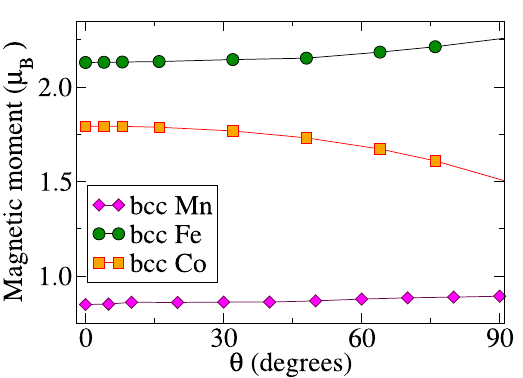
Figure 8. Obtained values of the rotated magnetic moment in the FM environment as a function of the rotation angle θ in considered bcc